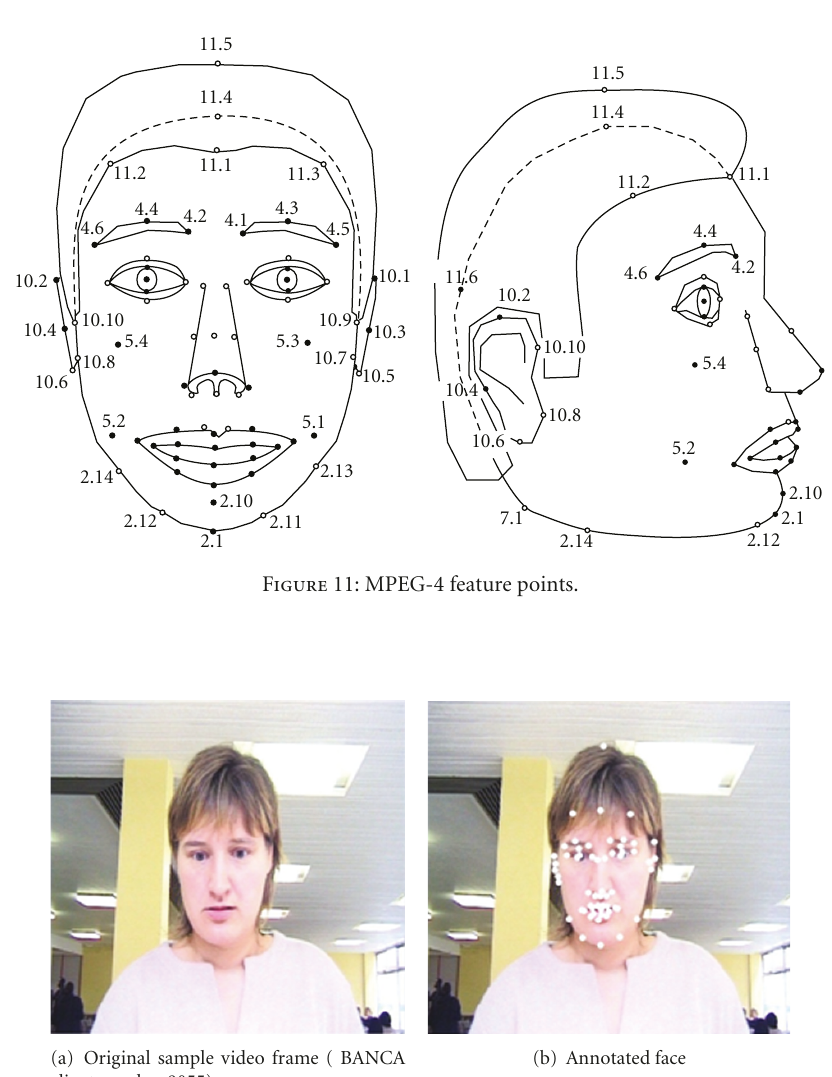
Figure 12: Feature point annotation on the BANCA